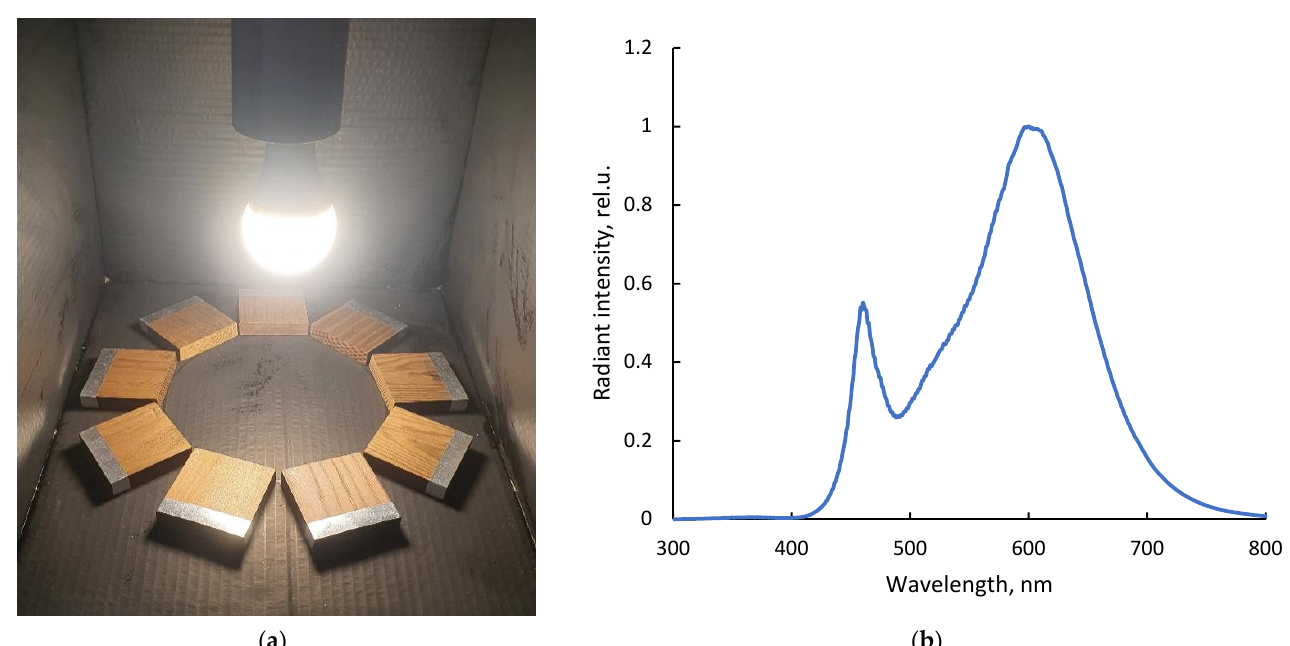
Figure 1. Chamber for exposure to LED lamps ( a ) and spectral composition of the LED lamps used in the experiments ( b ).